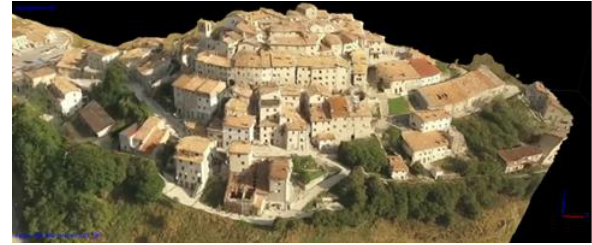
Figure 2. 3D model of Castelluccio before the earthquake